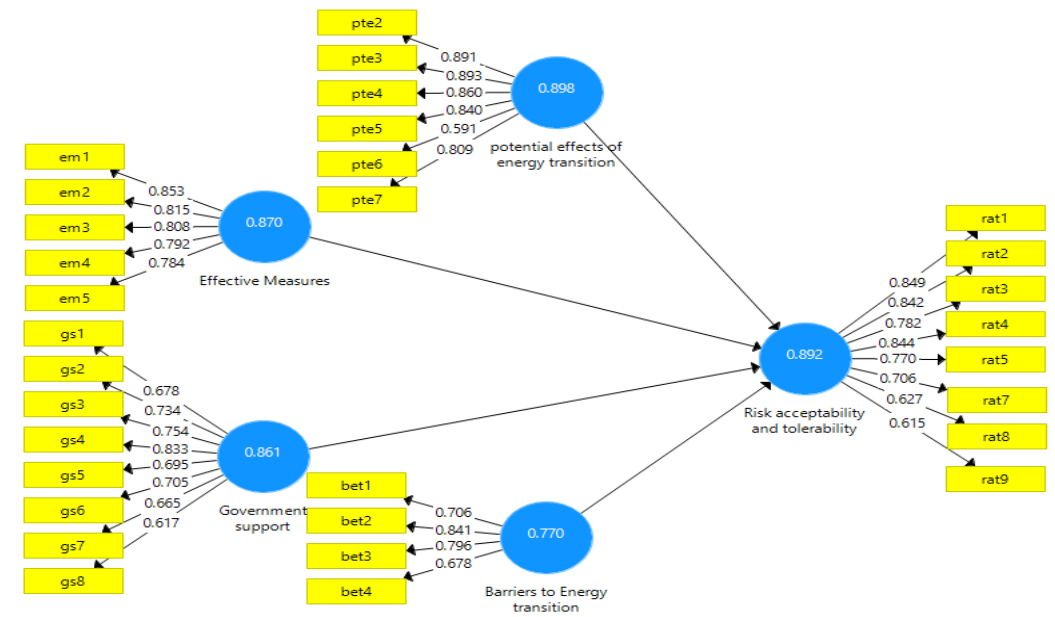
Figure 2. Factor Loadings.